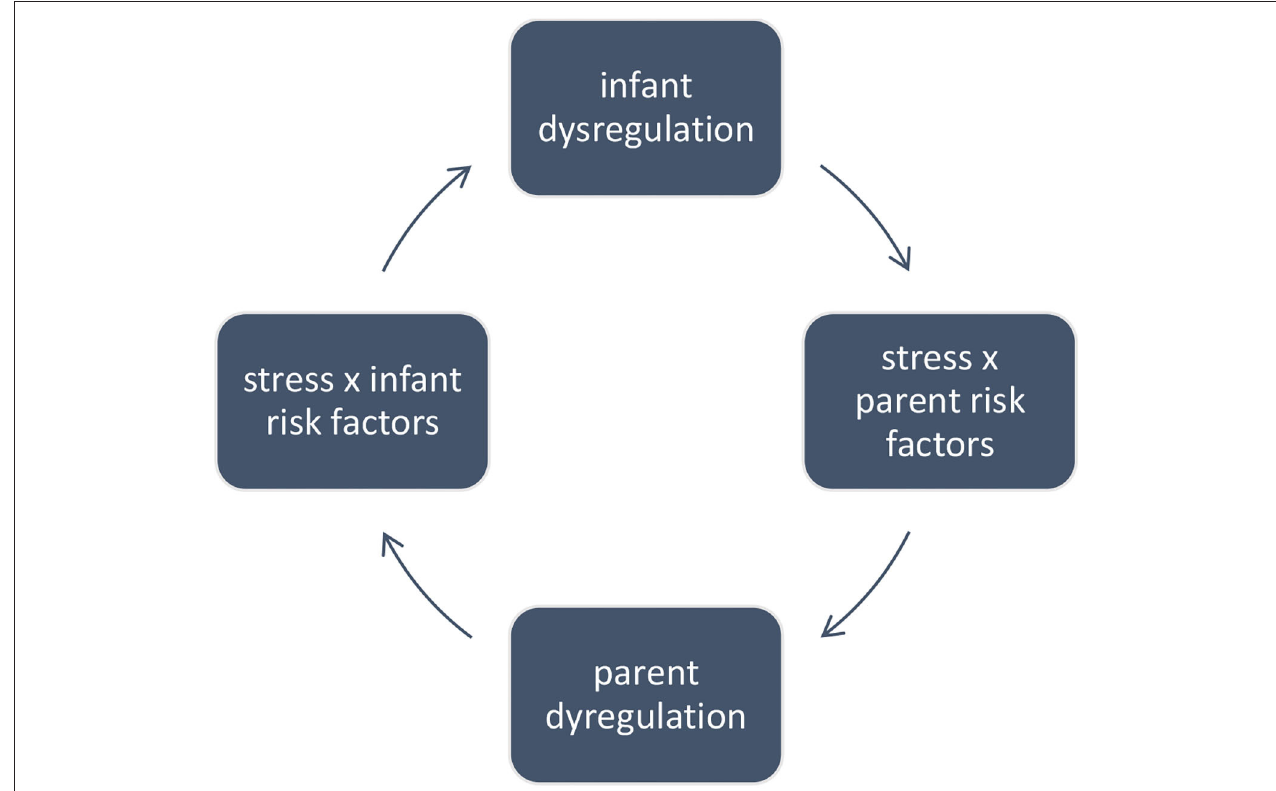
FIGURE 1 | The mutual dysregulation spiral